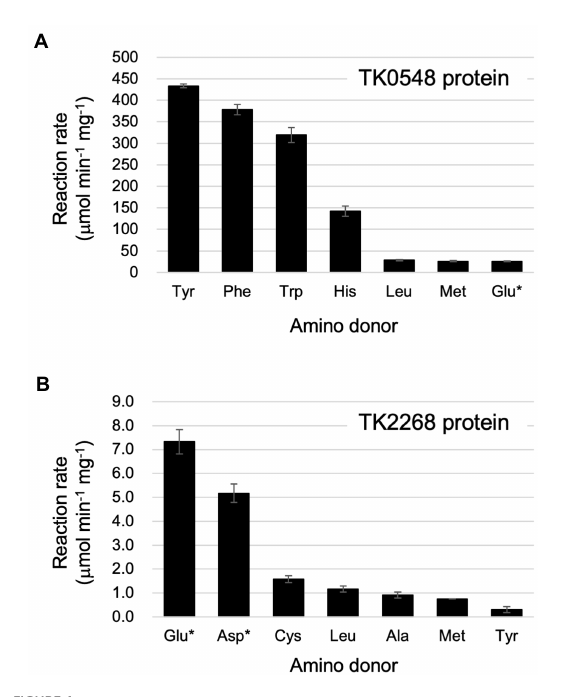
FIGURE 4 Reaction rates of the recombinant TK0548 (A) and TK2268 (B) proteins with various amino donors. Each protein was incubated for varying periods of time at 80 ° C with the indicated amino acids and 2-oxoglutarate or pyruvate (indicated with asterisks), and the reaction rates of Glu or Ala production, respectively, were calculated. Amino donors and acceptors were added at a concentration of 10 mM (Tyr: 6 mM). The results are the means of three independent assays and error bars indicate standard deviations.